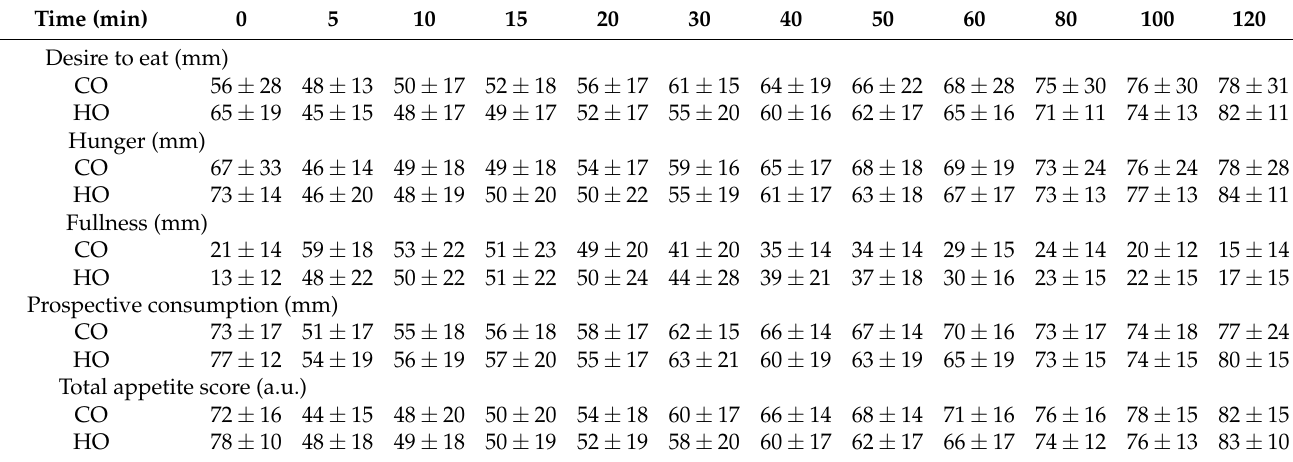
Table 1. Participants’ appetite scores (mean values and standard deviations) in Experiment 1.